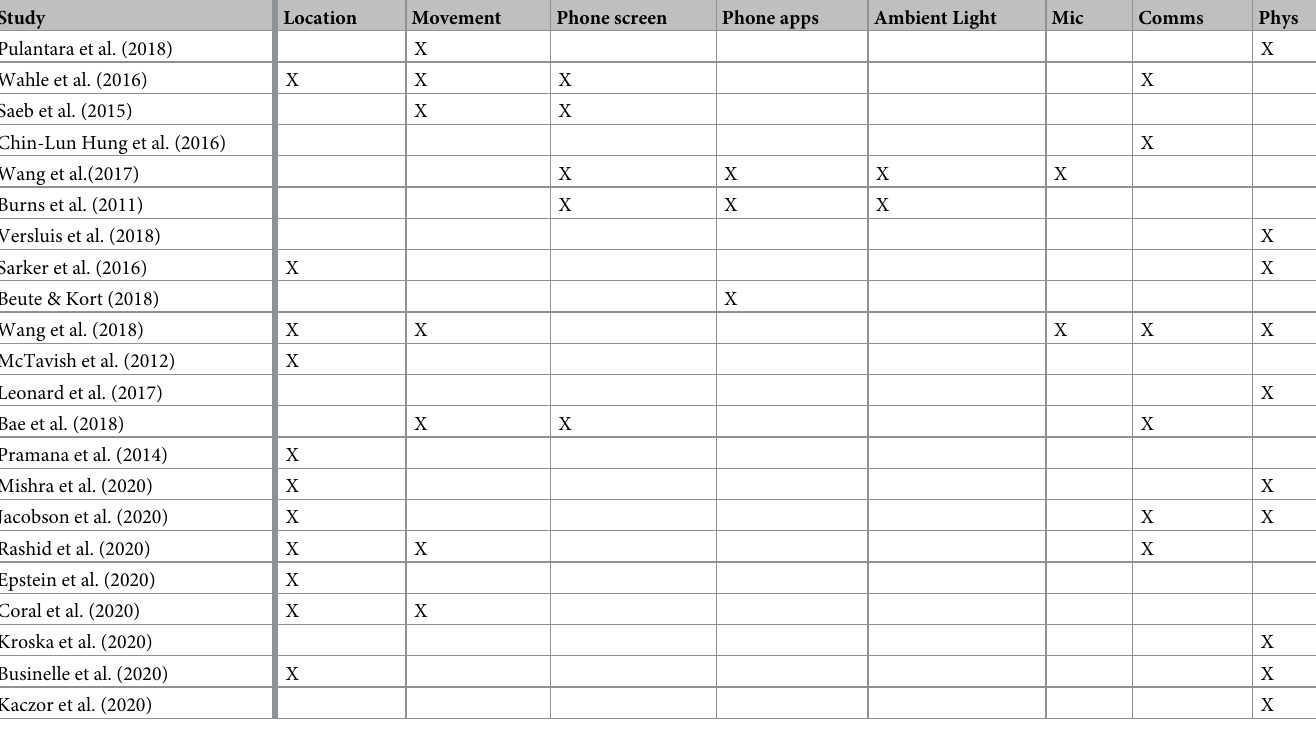
Table 3. Sensors for automated data